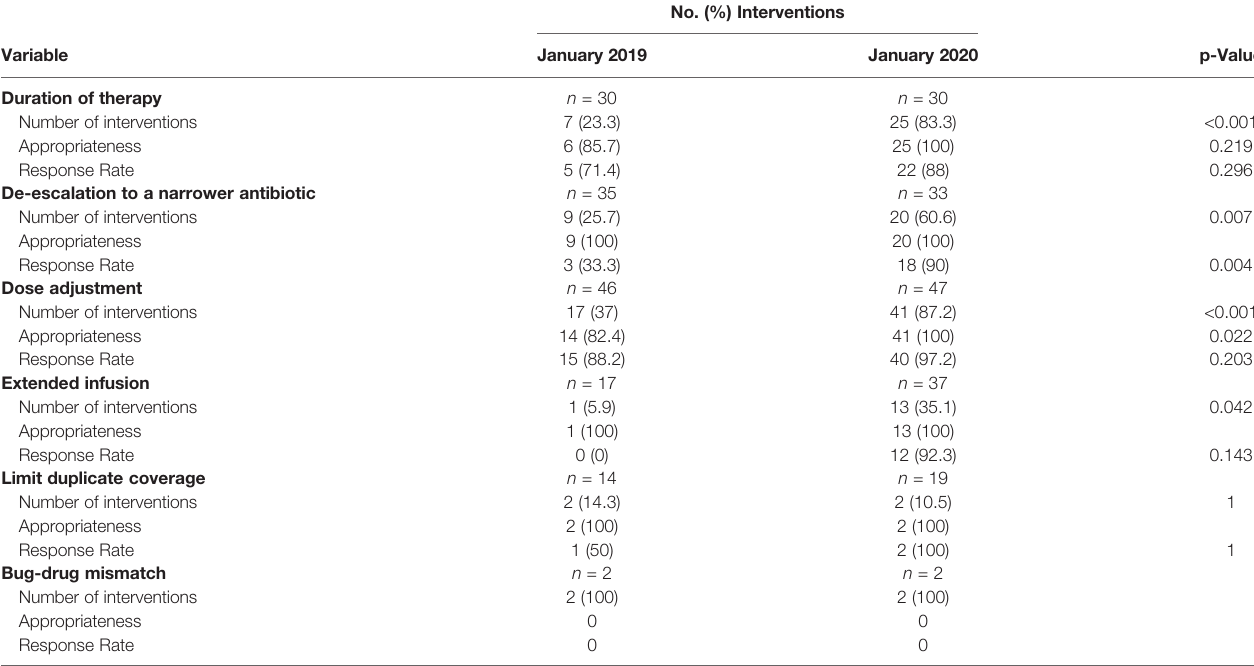
TABLE 3 | Pharmacists ’ interventions: subtypes, appropriateness, and response rate in January 2019 and January 2020.